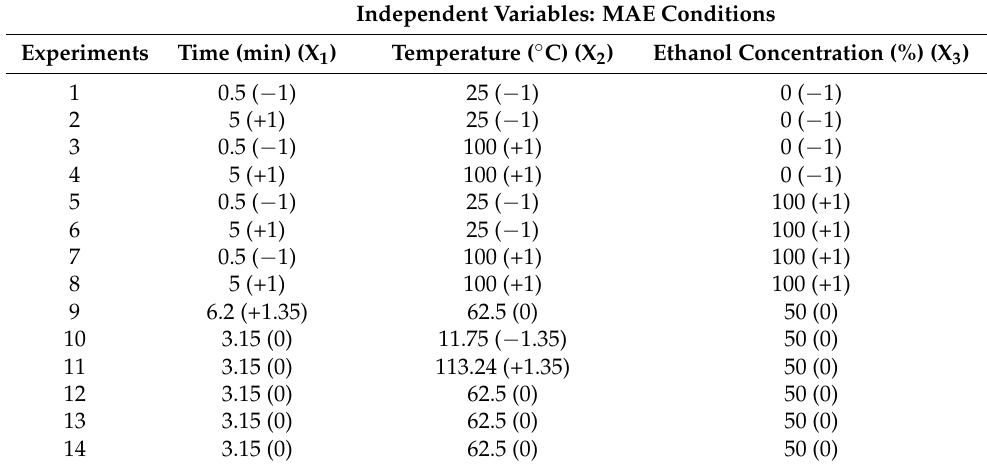
Table 1. The CCO matrix of MAE of the experimental